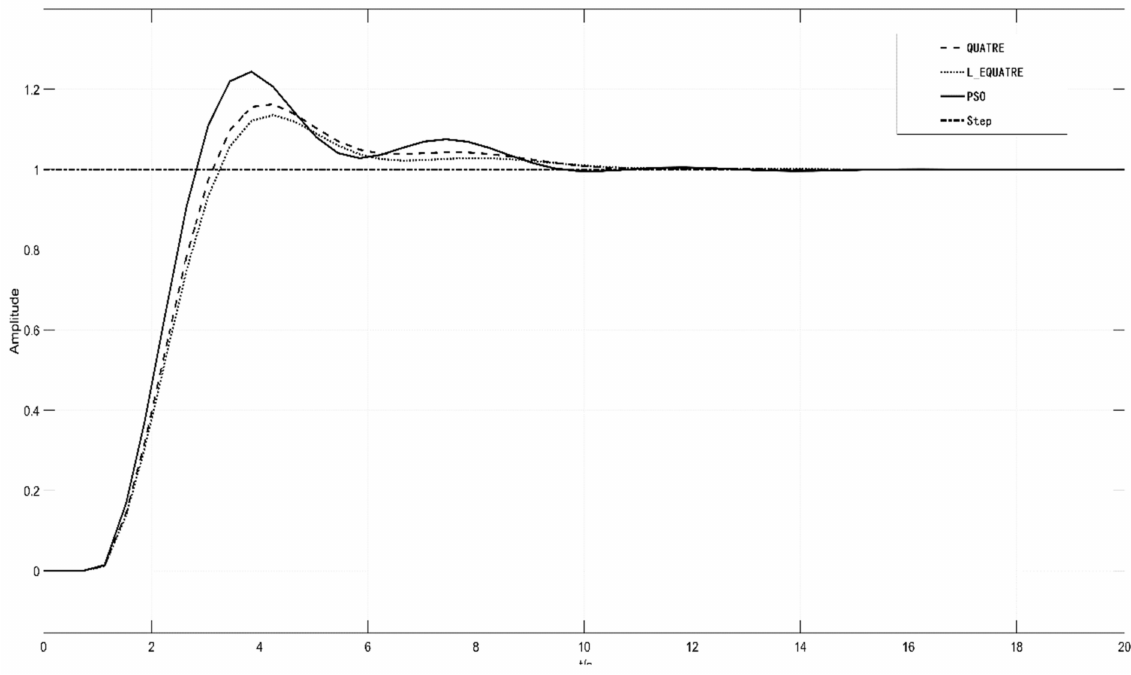
Figure 7. The unit response curve of the second-order controlled